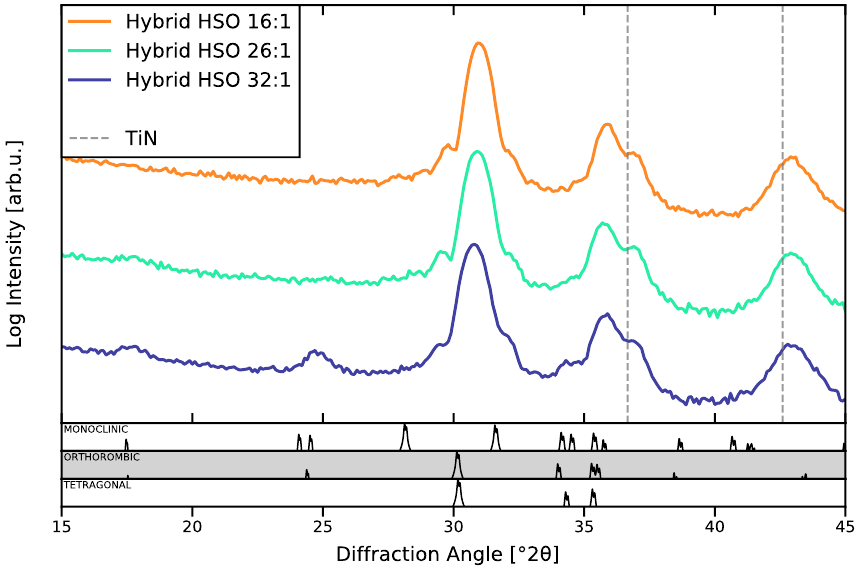
Figure 2. Grazing incidents X-ray diffraction of HSO films deposited with the hybrid process.